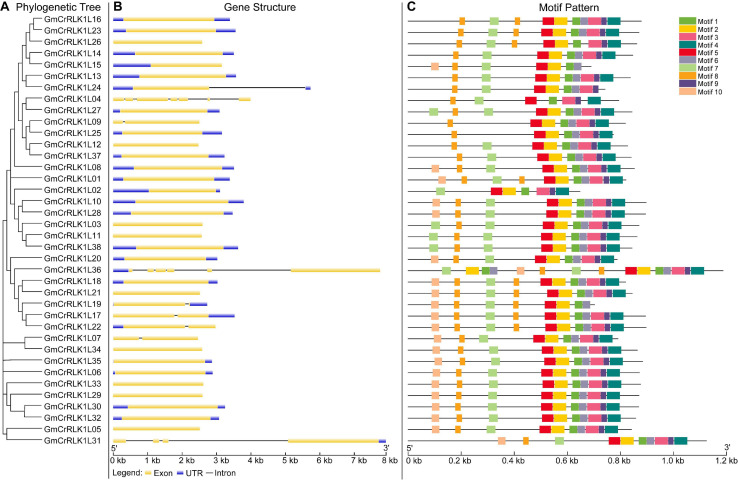
Phylogenetic relationship, gene structure, and architecture of conserved protein motif in CrRLK1L genes from soybean. (A) The phylogenetic tree analysis of CrRLK1L genes from soybean. (B) Exon/intron organization of GmCrRLK1L genes. Yellow boxes represent exons and black lines represent introns. (C) The motif composition of soybean CrRLK1L proteins. The motif, numbers 1–10, are displayed in different color boxes. For details of motifs refer to Table 2.